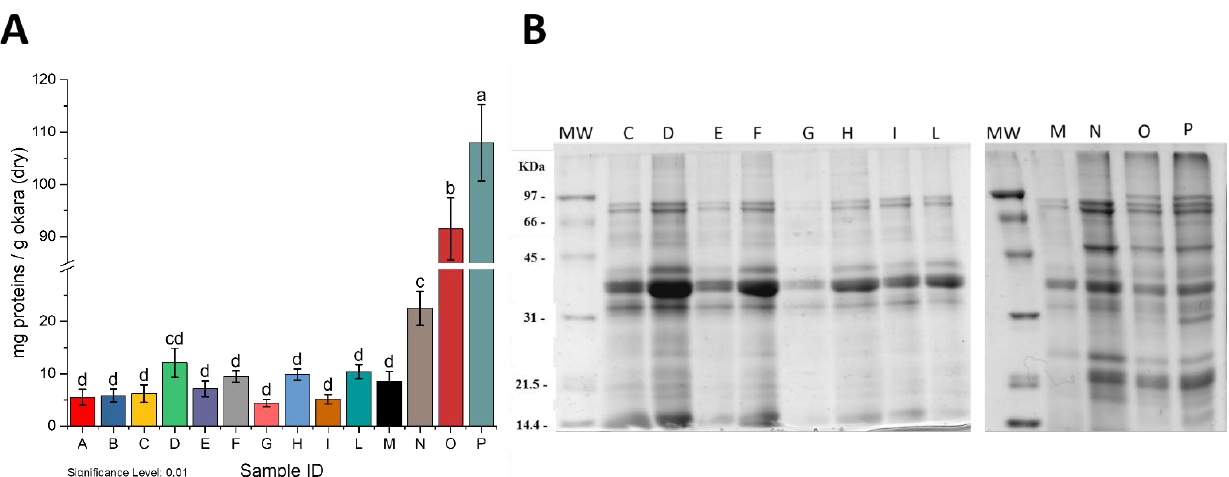
Figure 1. Quantitative ( A ) and qualitative ( B ) analysis of proteins extracted from dry okara in the different tested conditions.